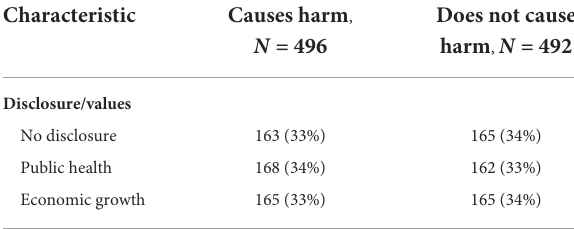
TABLE 1 Assignment of participants to